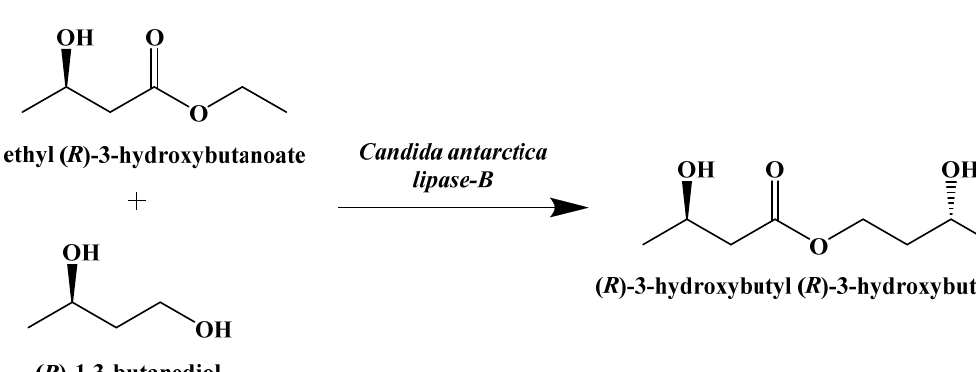
Figure 17. Enzymatic Synthesis of (R)-3-hydroxybutyl (R)-3-hydroxybutanoate.